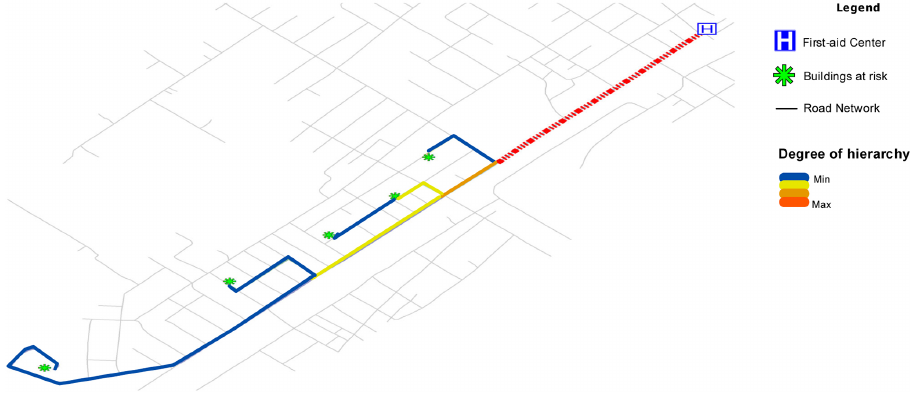
Figure 6. Graphical example of the degree of hierarchy of arches that can be utilized by emergency services during the shortest paths that connect “origin” (e.g. a first-aid centre) with diverse destinations (i.e. the buildings at risk).